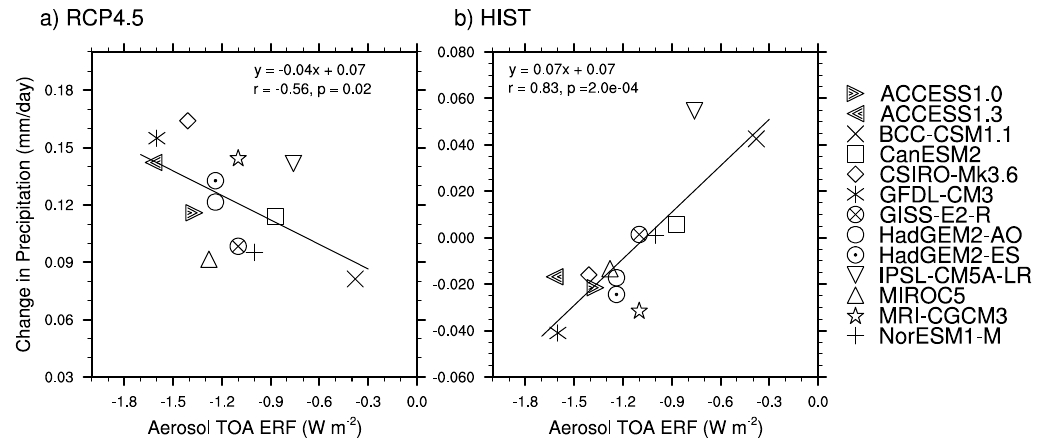
Fig. 11. Changes in global-mean precipitation from CMIP5 models plotted against (2000 relative to 1850) global-mean aerosol ERF diag- nosed from fixed-SST simulations: (a) RCP4.5 (2006–2100), (b) historical simulations (1850–2005). Precipitation changes are calculated from least-squares trends. Also shown in each panel are the regression line, the equation for the regression line, the correlation and the level of